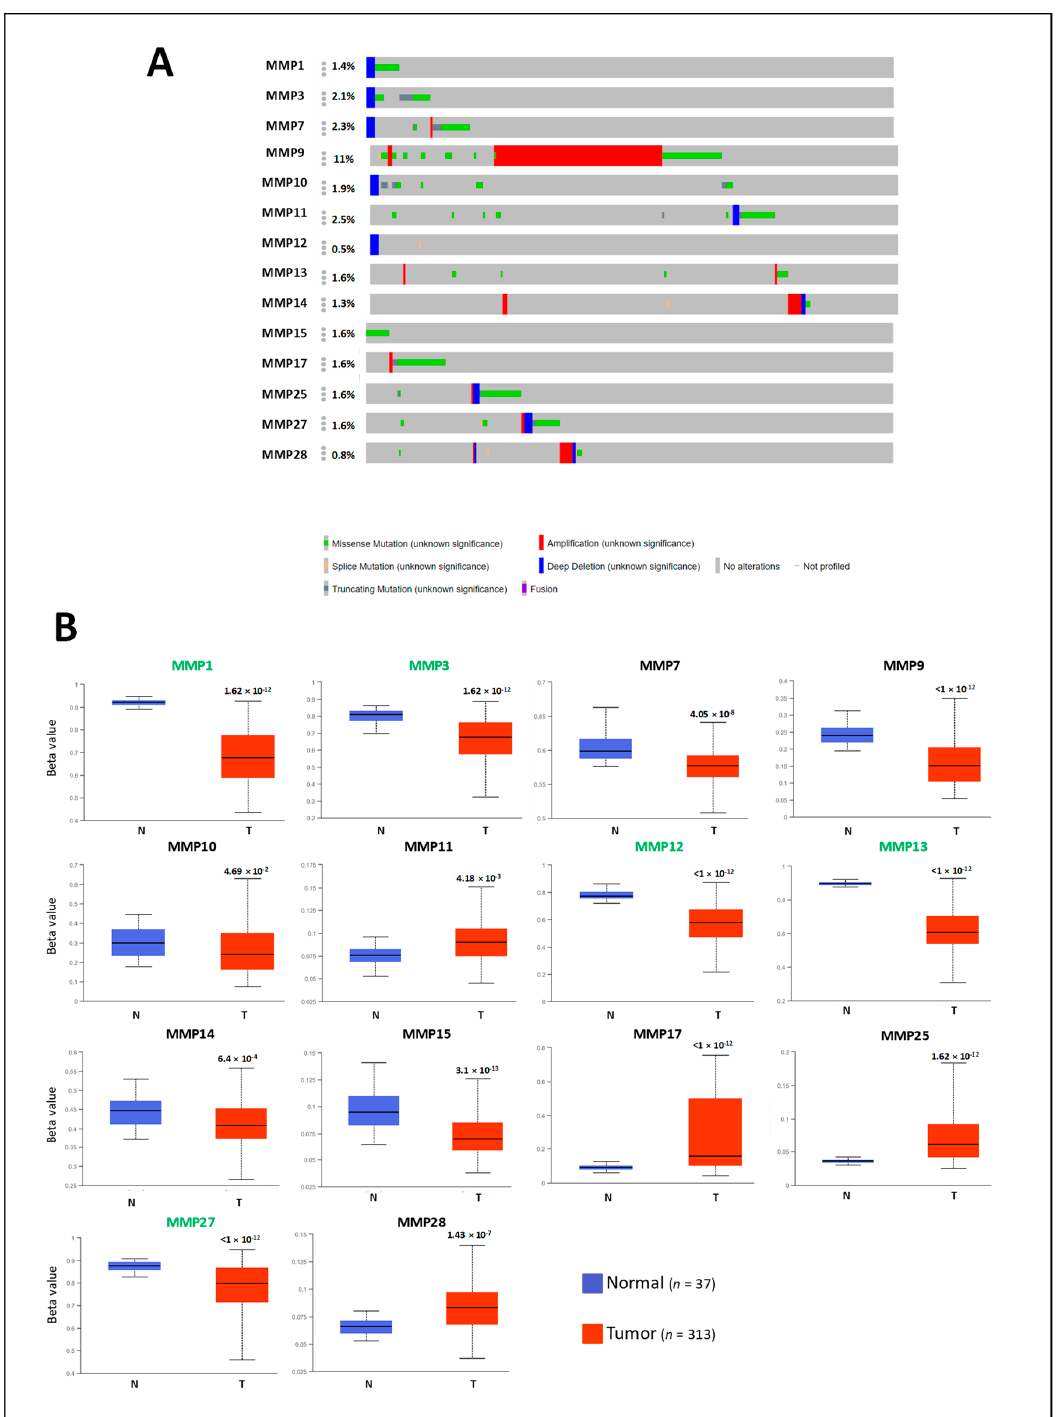
Figure 2. Analysis of genetic and epigenetic alterations of MMP members differentially expressed in CRC. ( A ) The percentage of MMPs alterations was retrieved by using the OncoPrint tool of cBioPortal. Red and blue represent amplification, and deep deletion, respectively; green and grey represent missense and truncating mutations. ( B ) Box plots showing the MMPs promoter methylation status between normal and CRC, retrieved from the UALCAN database. Beta value indicates level of DNA methylation ranging from 0 (un methylated) to 1 (fully methylated). Different Beta value cut-off has been considered to indicate hypermethylation [beta value: 0.7–0.5] or hypomethylation [beta-value: 0.3–0.25]. MMP members with hypermethylated promoters are marked in green; MMP members with hypomethylated promoters are marked in black. p < 0.01 was considered significant.